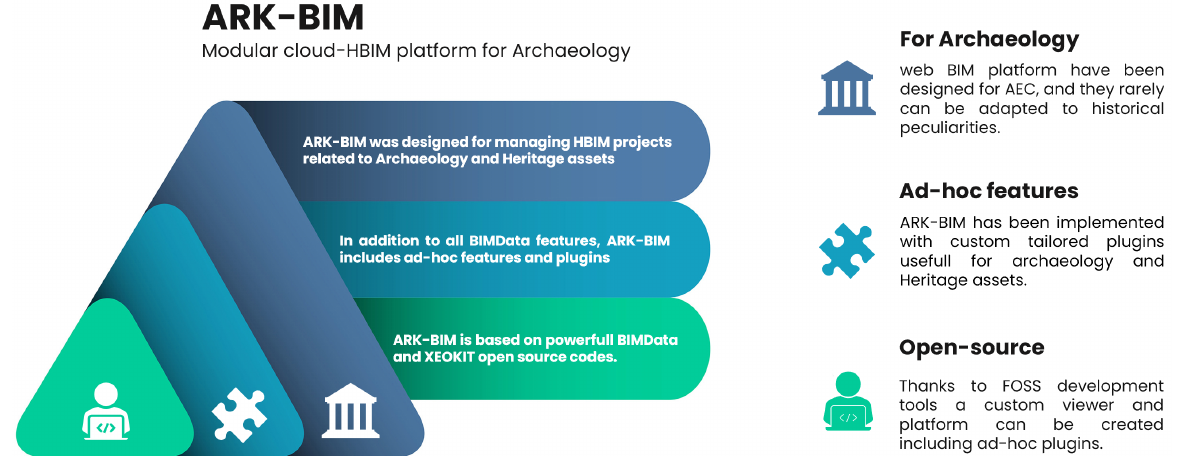
Figure 22. ARK-BIM main features: a modular platform for archaeology, which includes ad-hoc plugins, built with open-source web instruments.